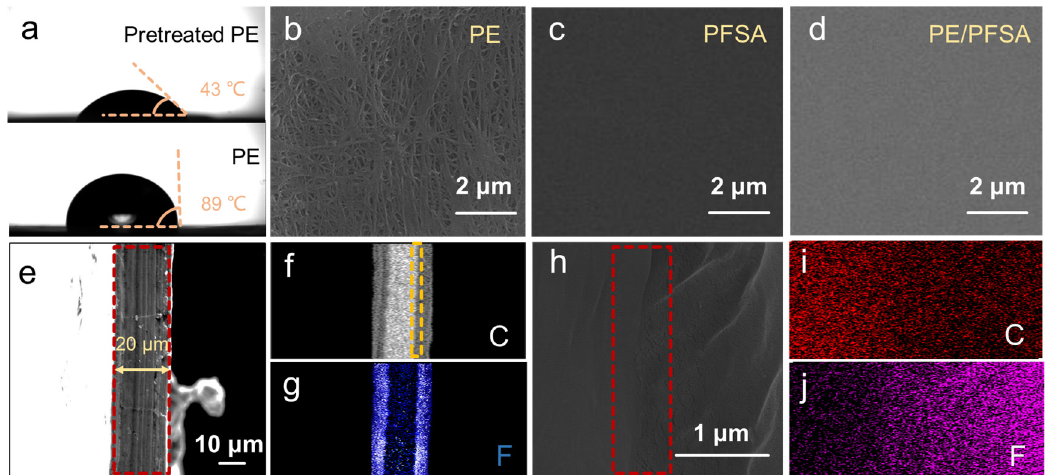
Figure 2. ( a ) Water contact angles of the original PE and the pretreated PE; surface morphologies of ( b ) PE, ( c ) pure PFSA, and ( d ) PE/PFSA; ( e ) cross-section morphology of PE/PFSA; ( f , g ) EDS mapping of ( e ) with C and F elements; ( h ) high-magnification SEM image of the interface in the selected area in Figure 2f; and ( i , j ) EDS mapping of ( h ) with C and F elements.